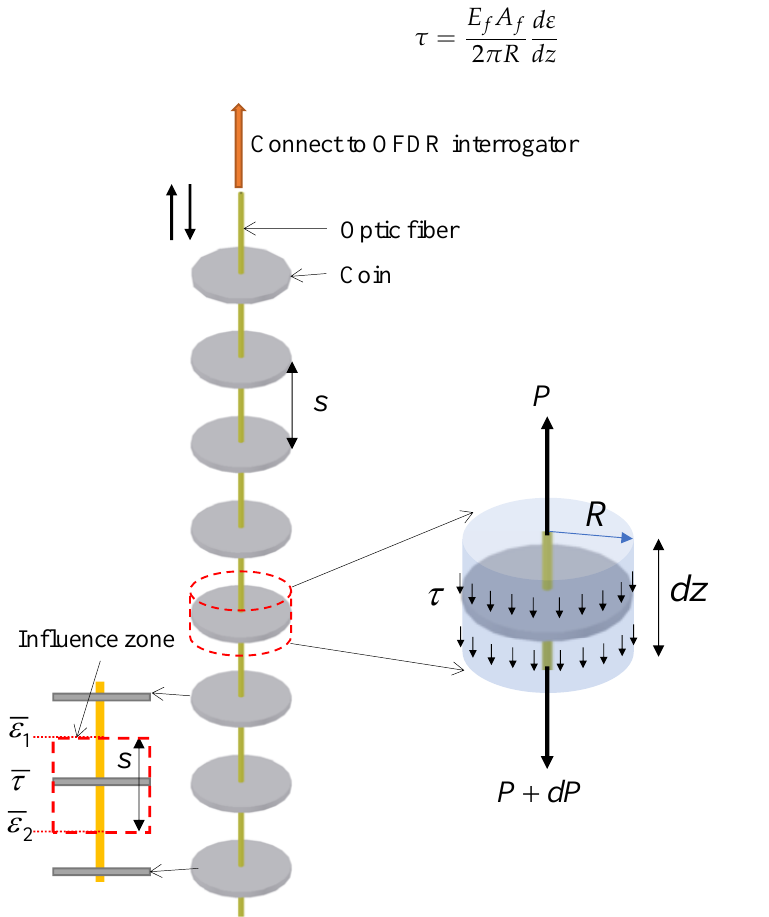
Figure 2. Illustration of the working principle of the OFDR coin sensor.